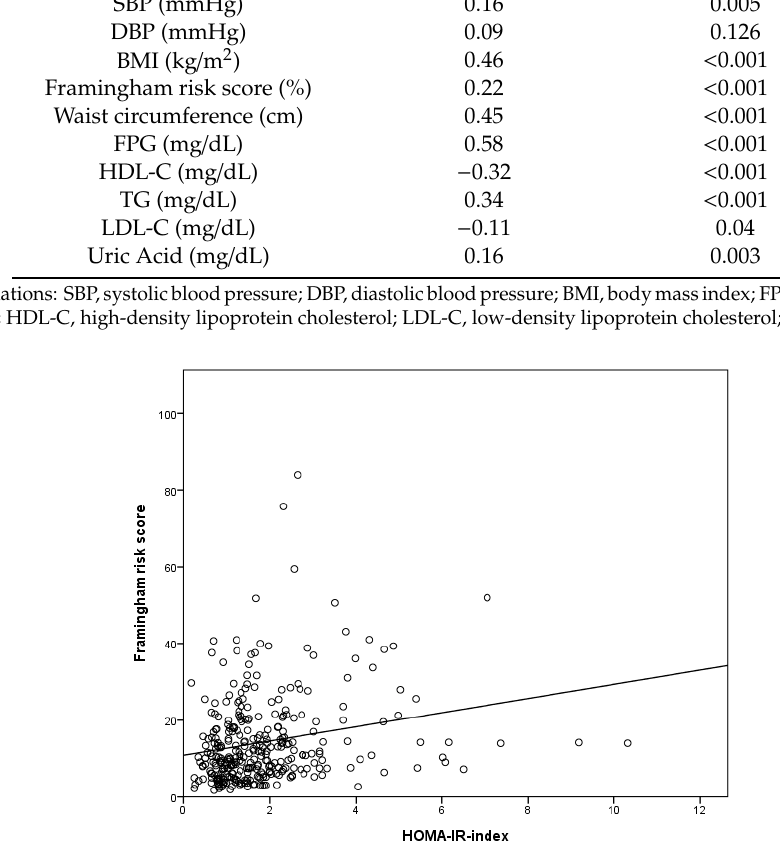
Figure 2. Correlation coefficients between the HOMA-IR levels and the Framingham risk score.